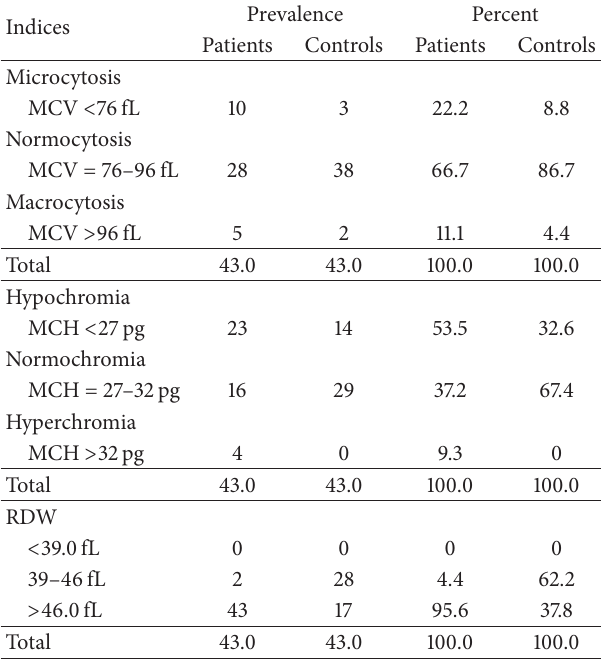
Table 2: Prevalence of microcytosis, macrocytosis, hypochromia, hyperchromia, and red cell distribution width in patients and